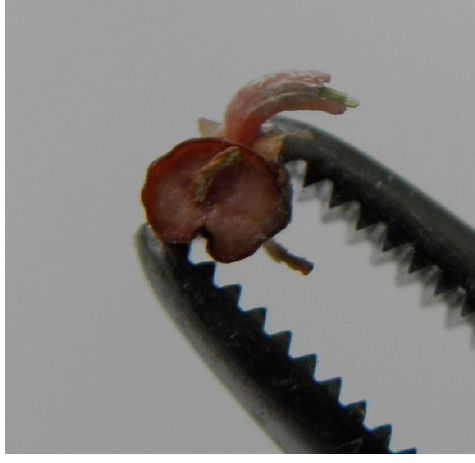
Figure 3. Fusarium -infected wheat malt grain.